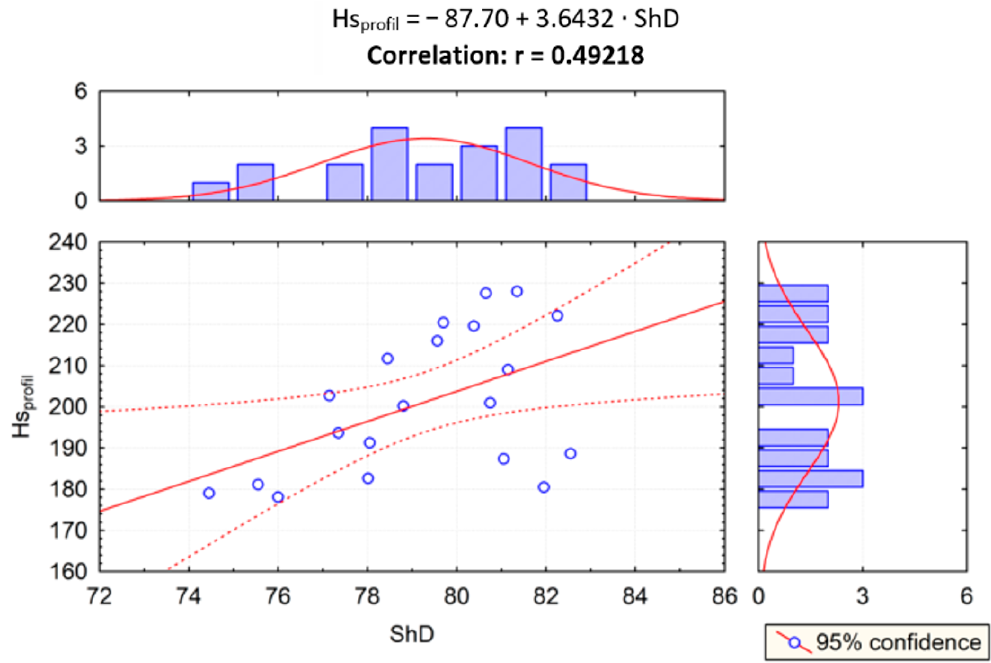
Figure 16. Dependence between scratch hardness Hs profil and Shore hardness ShD (r—correlation).